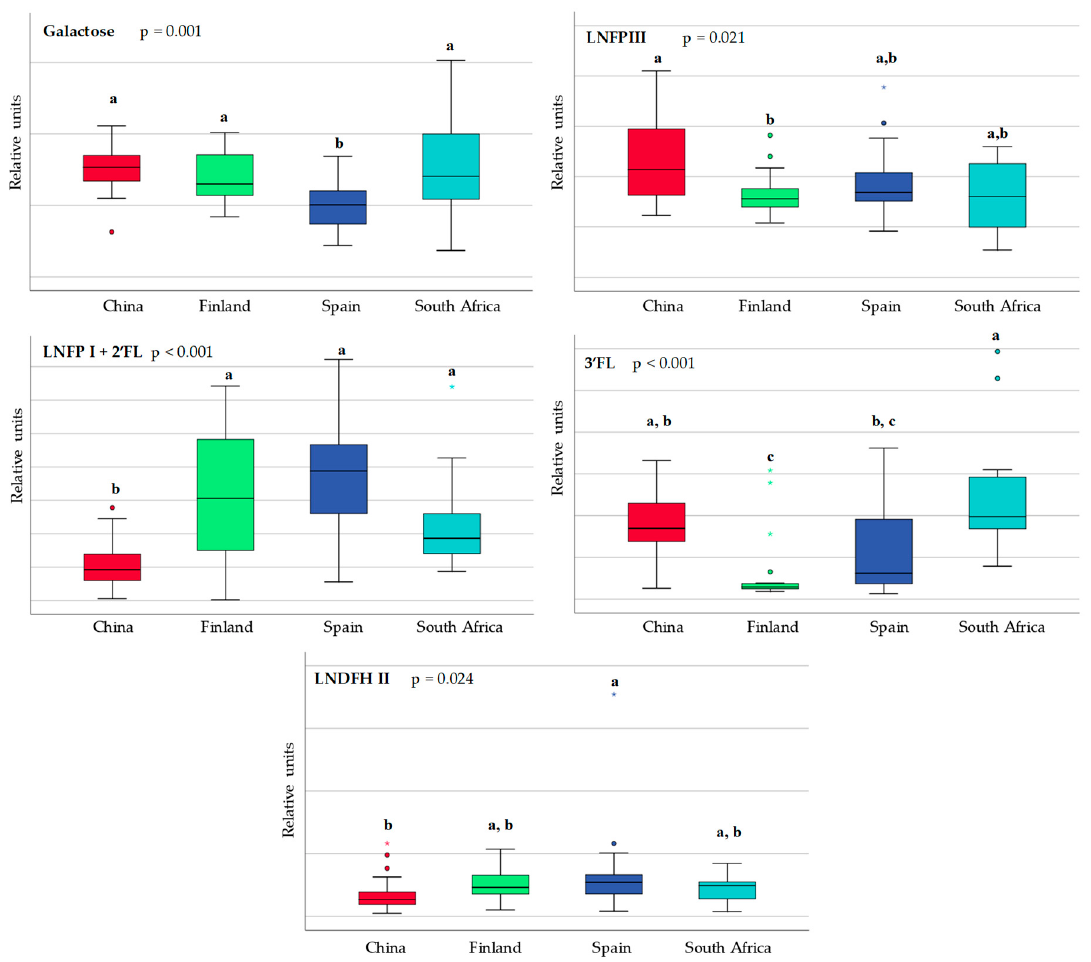
Figure 2. Box and whisker plot showing statistical significant differences in sugars and derivatives in breast milk obtained from China (red), Finland (green), Spain (blue) and South Africa (pale blue). Each bar represents the smallest observation, lower quartile ( Q1 ), median, upper quartile ( Q3 ) and largest observation. Differences among countries were calculated using the Kruskal - Wallis test. Unlike letters indicate statistically significant differences among countries. Circles and stars indicate outlier data. 3 ′ FL: 3-fucosyllactose; LNFP I + 2 ′ FL: lacto- N -fucopentaose I and 2-fucosyllactose; LNDFHII: lacto- N -difucohexaose II; LNFP III: lacto- N -fucopentaose III. Data are expressed in relative units.